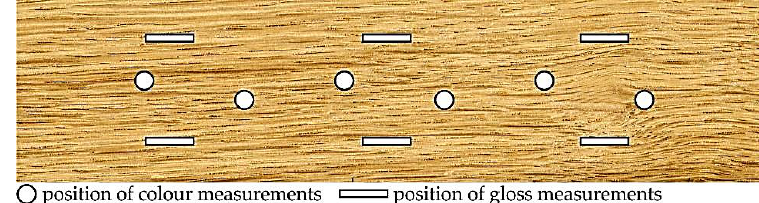
Figure 1. Scheme of colour and gloss measurements on the surfaces of tested oak wood samples.